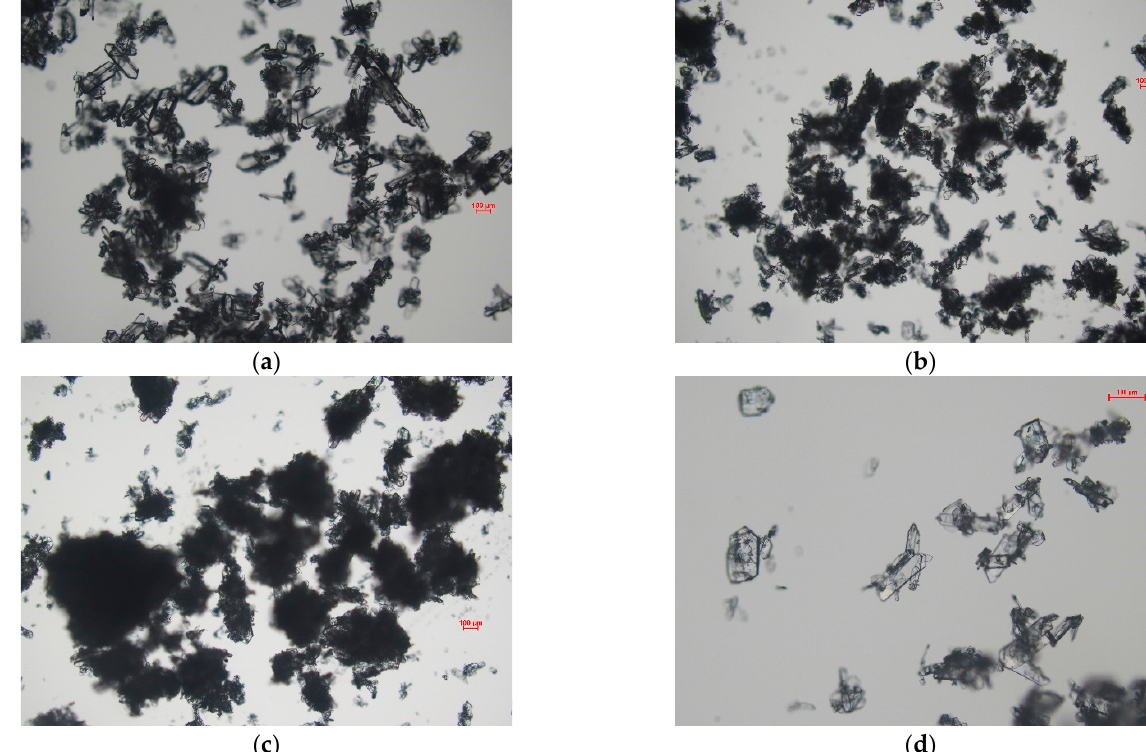
Figure 4. Microscopic images of ibuprofen crystals harvested from unseeded crystallization with starting concentrations of ( a ) 80, ( b ) 100 and ( c ) 140 mg/g solvent; ( d ) microscopic image of the primary particles in agglomerates at higher magnification than the previous three images. The scale bar stands for 100 µm.